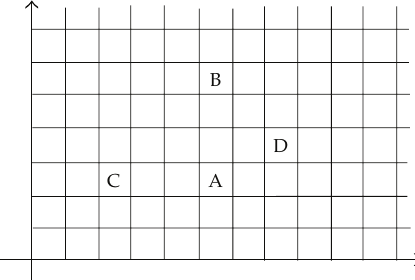
Figure 7: Two-dimensional space with 4 masses.